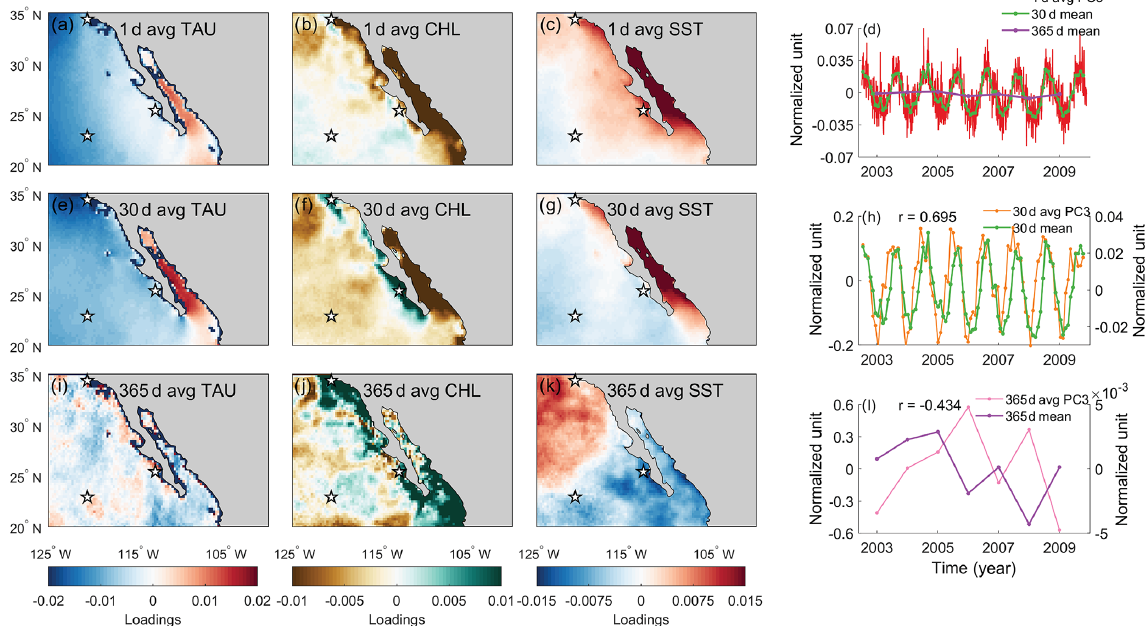
Figure 7. EEOF3 spatial and temporal patterns of TAU, CHL, and SST using (a–d) daily, (e–h) 30d averaged, and (i–l) 365d averaged data. Stars in the spatial pattern plots indicate locations where the differences were taken to compute cross-shore and meridional gradients. 30d mean (green) and 365d mean (purple) time series were derived from averaging 1d average PC3. The correlation coefficient indicates how well the time mean of 1d average PC tracks the PC of the time-averaged